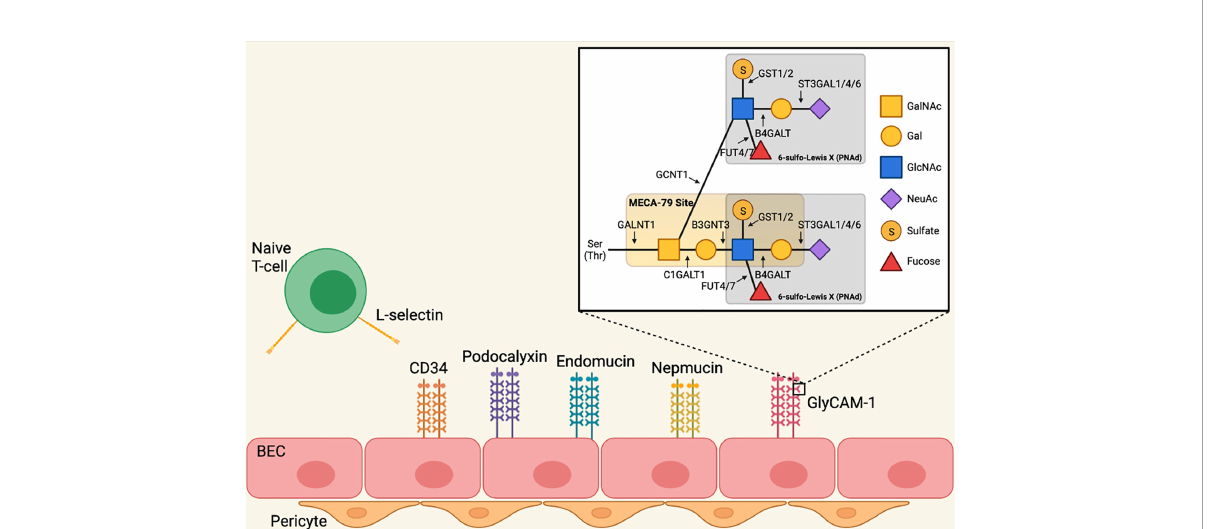
FIGURE 1 Biosynthesis of peripheral node addressin in lymph node blood endothelial cells. PNAd refers to the 6-sulfo sialyl Lewis X carbohydrate structure that is displayed on O -linked glycans that decorate multiple mucin-domain containing scaffolding proteins. Generation of 6-sulfo sialyl Lewis X involves a series of post-translational modi fi cations mediated by glycosyl transferases. Polypeptide N -acetylgalactosaminyltransferase 1 (GALNT1) initiates formation of the O -linked glycan by attaching a N -acetyl-galactosamine (GalNAc) residue to serine and/or threonine (35). O - glycans are biantennary structures consisting of Core 1 and Core 2 branches. Glycoprotein- N -acetylgalactosamine 3-beta-galactosyltransferase 1 (C1GALT1, Core 1 synthase) creates the core 1 branch by attaching a galactose (Gal) residue to the O-linked GalNAc residue (36, 37), and this branch is extended by the addition of N -acetylglucosamine (GlcNAc) by beta-1,3- N -acetylglucosaminyltransferase 3 (B3GNT3) (37). The Core 2 branch is created by Beta-1,3-galactosyl-O-glycosyl-glycoprotein beta-1,6- N -Acetylglucosaminyltransferase 1 (GCNT1, Core 2 synthase), which attaches a GlcNAc residue to the O -linked GalNAc (38). The GlcNAc residues of the Core 1 and Core 2 branches are each modi fi ed in 3 additional ways. Galactose/N-acetylglucosamine/ N -acetylglucosamine 6-O-sulfotransferase 1 (GLCNAC6ST-1) and 2 (GLCNAC6ST-2) attach sulfate onto the Core 1 and Core 2 GlcNAc residues, although GLCNAC6ST-1 acts only inef fi ciently to modify Core 1 (39 – 42). Alpha- (1, 3)- fucosyltransferase 4 (FUT4) (43) and 7 (FUT7) (44) attach fucose to both Core 1 and Core 2 GlcNAc residues. Finally, beta-1,4- galactosyltransferase (B4GALT) attaches Gal residues to GlcNAc in both branches (45), which are then further modi fi ed by CMP-N- acetylneuraminate-beta-galactosamide-alpha-2,3-sialyltransferase 1 (ST3GAL1) (46), 4 (ST3GAL4) (47), and 6 (ST3GAL6) (48), which attach N - acetylneuraminic acid (NeuAc) to Gal. This completes formation of the 6-sulfo sialyl Lewis X structure that is recognized by L-selectin expressed on naïve and central memory T- and B-cells. Image created with